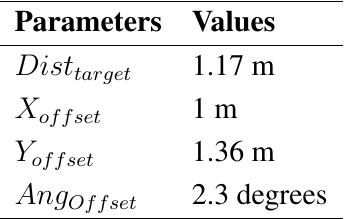
Table 1. Parameters to calculate the front control